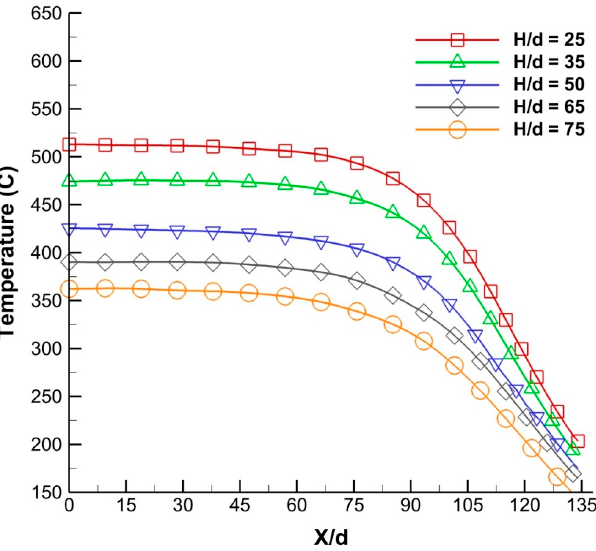
Figure 15. Effect of the distance from the gas torch on the temperature distribution on the back side of the steel plate along the x-direction from the center to the edge.